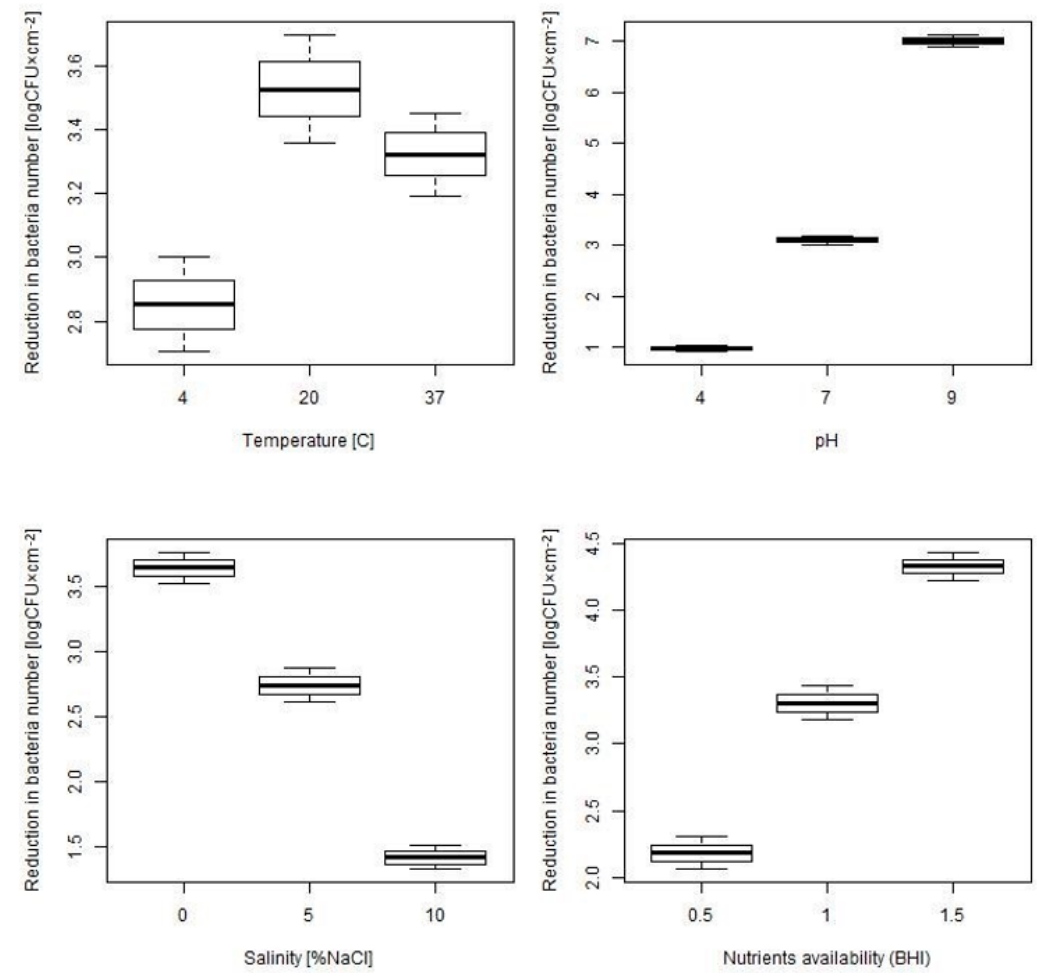
Figure 3. Resistance to disinfection of biofilm formed under different environmental conditions, expressed as decreases in the number of bacteria isolated from the biofilm—the boxplots for mean with SE (standard error) and 95% confidence interval.